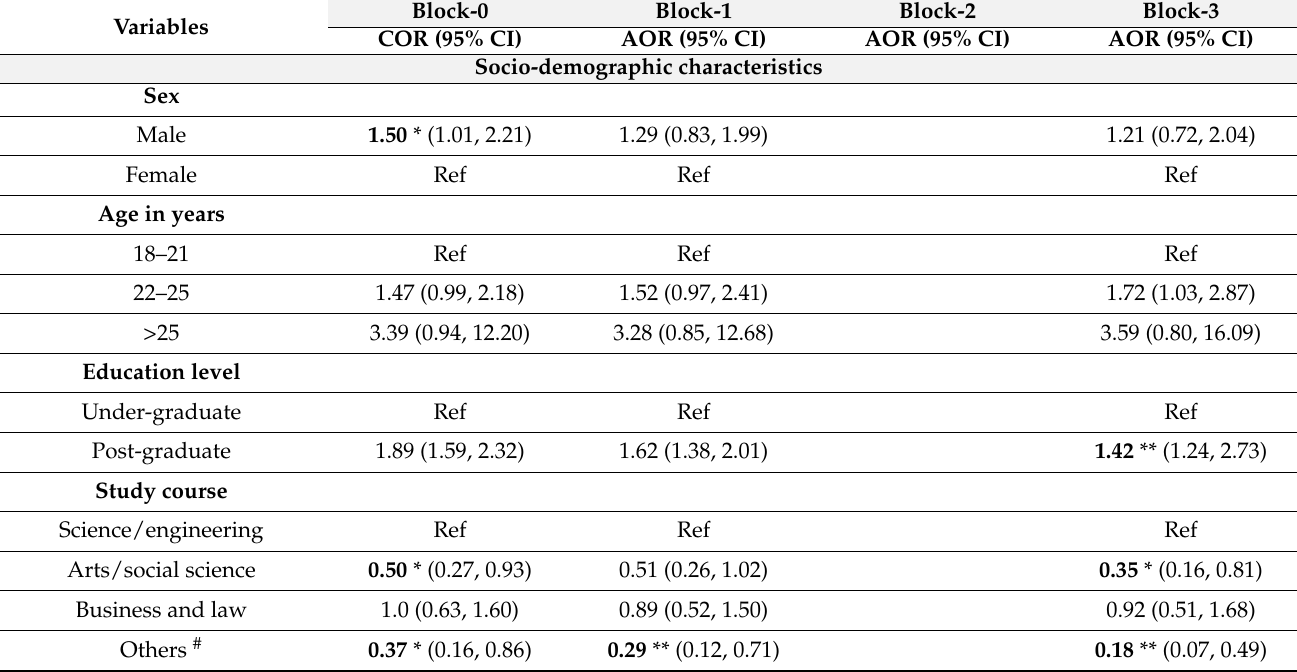
Table 3. Different models of regression analysis show the factors associated with study participants’ good diet